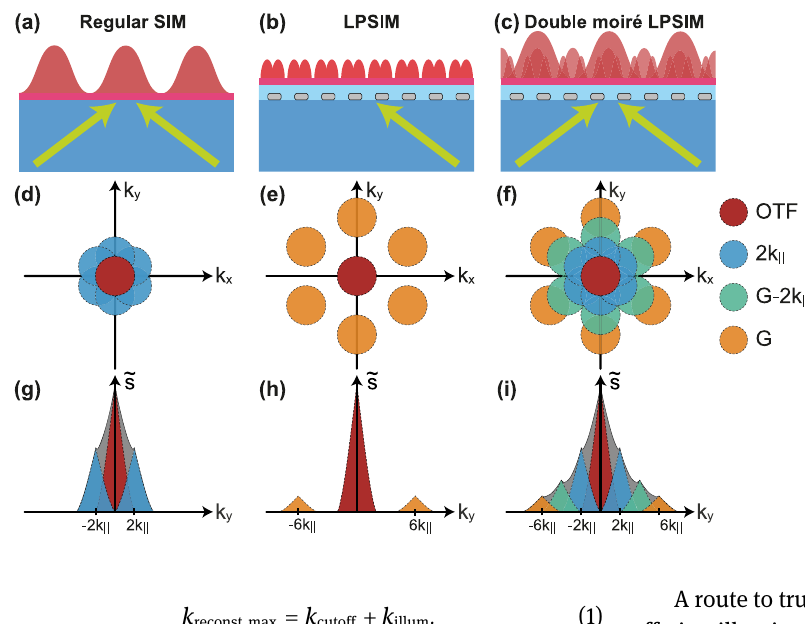
Figure 1: Concept of double moiré localized plasmon SIM